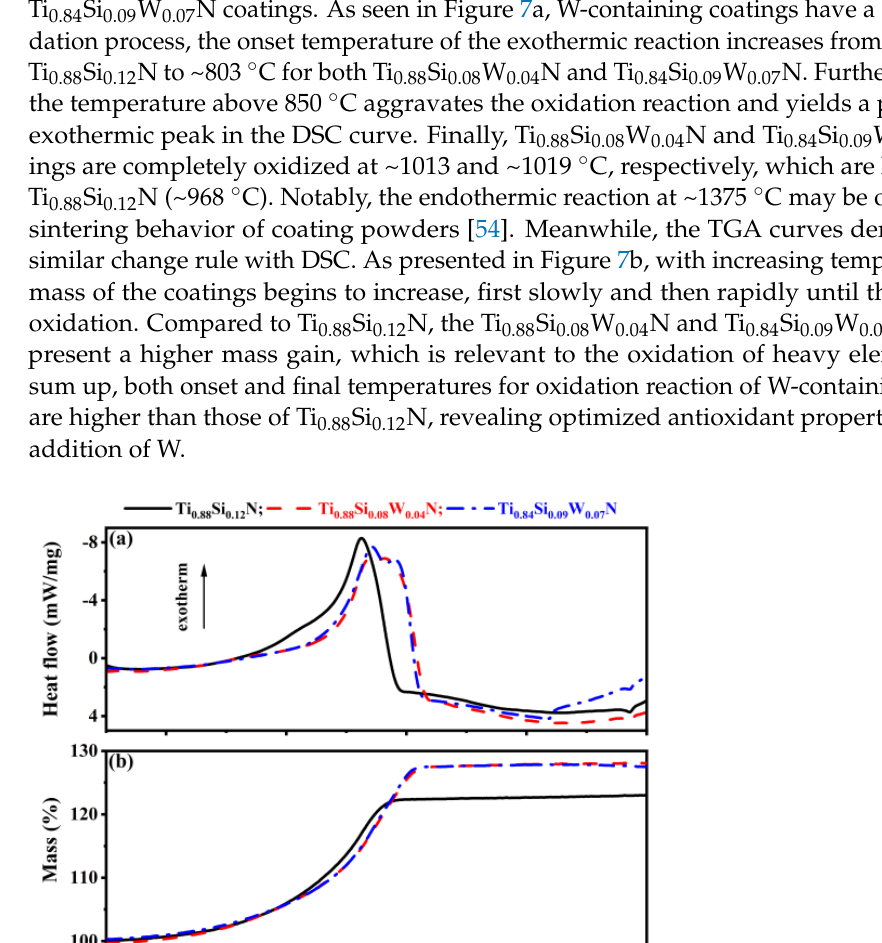
0.88 Si 0.12 N, Ti 0.88 Si 0.08 W 0.04 N, and Ti 0.84 Si 0.09 W 0.07 N coatings as a function of an-